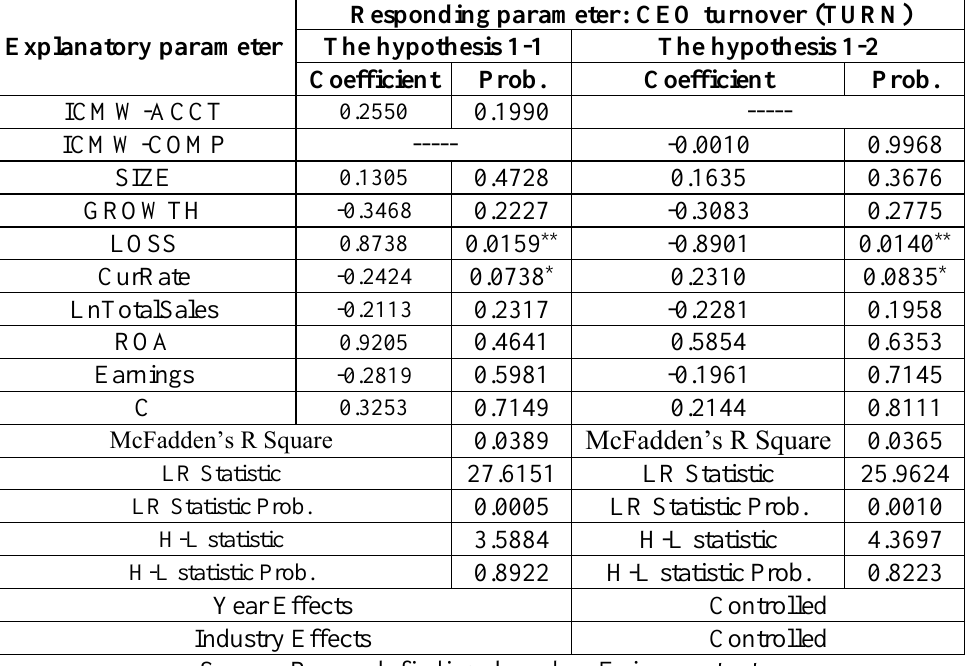
Table 4: Estimating the Logistic Model for the Sub-hypotheses Responding parameter: CEO turnover Explanatory parameter